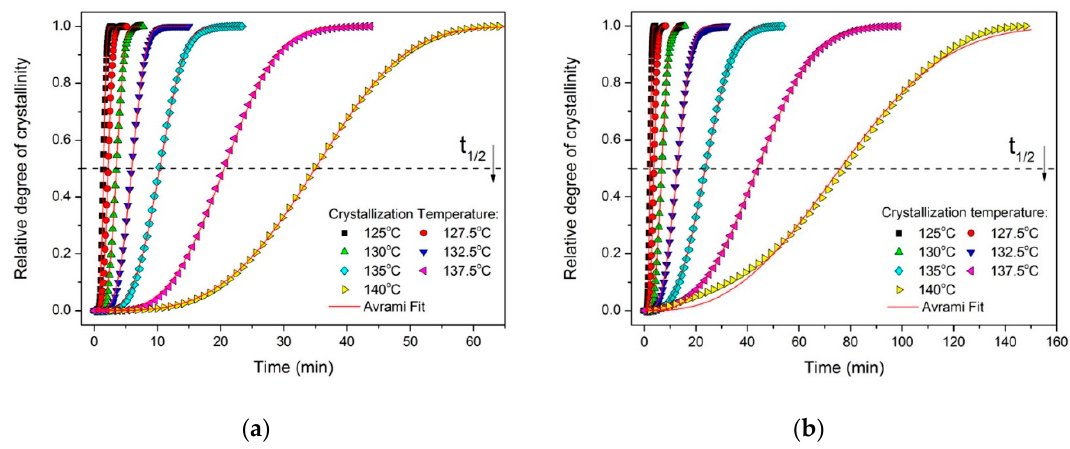
Figure 3. Avrami fit (continuous line) for the data (solid symbols) from the isothermal crystallization of ( a ) neat PP and ( b ) PP–GF10 composite.